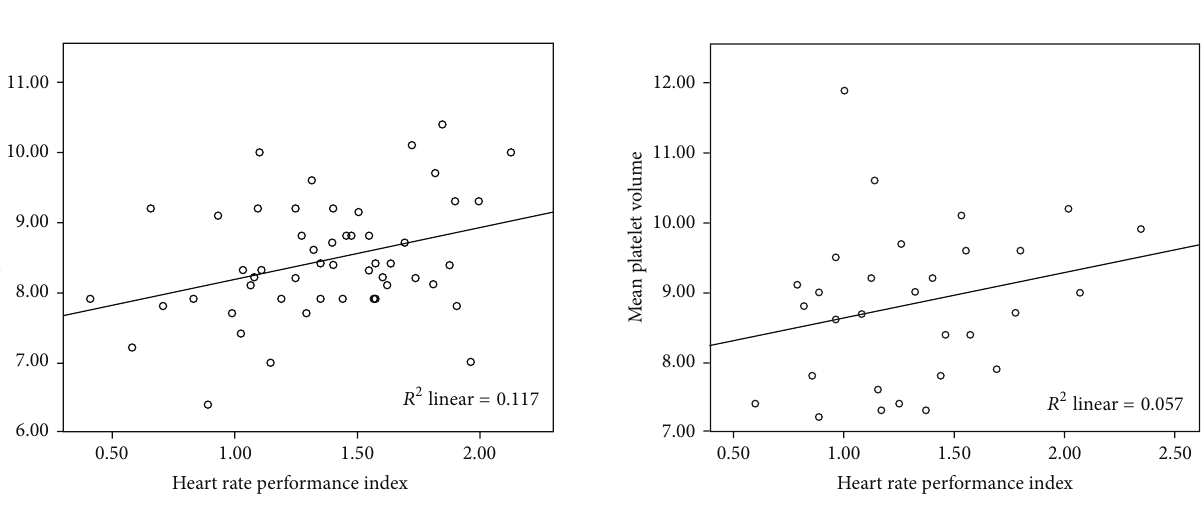
multivariate analysis, the platelet count ( 𝛽± SE: −0.004±0.002 , 95% CI, − 0.008 to − 0.001; 𝑃 = 0.034 ) and PRTS at SaO 2 < 90% ( 𝛽 ± SE: 2.93 ± 1.93 , 95% CI, 0.167 to 5.69; 𝑃 = 0.038 ) were significant variables associated with MPV (Table